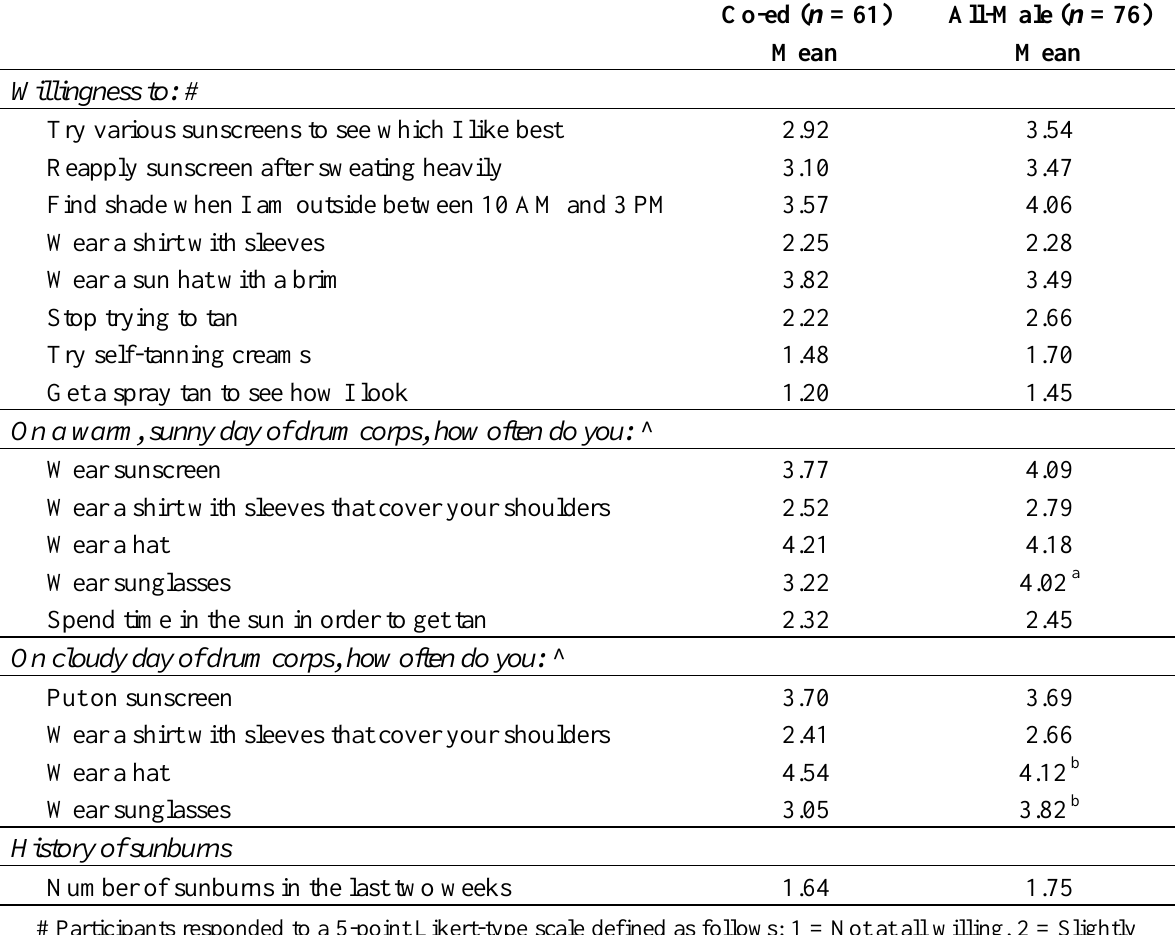
Table 3. Comparison of willingness to engage in sun protection and sun protection